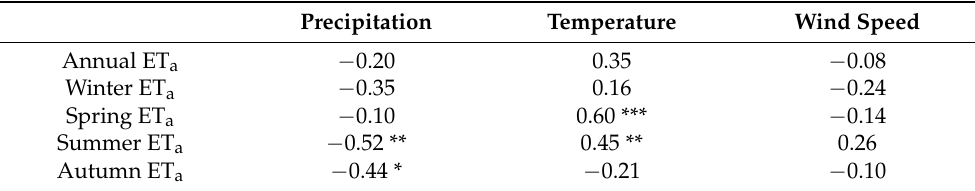
Table 4. The Pearson correlation coefficients of between climate variables and ET a from 2000 to 2019. Precipitation Temperature Wind Speed Annual ET a − 0.20 0.35 − 0.08 Winter ET a − 0.35 0.16 − 0.24 Spring ET a − 0.10 0.60 *** − 0.14 Summer ET a − 0.52 ** 0.45 ** 0.26 Autumn ET a − 0.44 * − 0.21